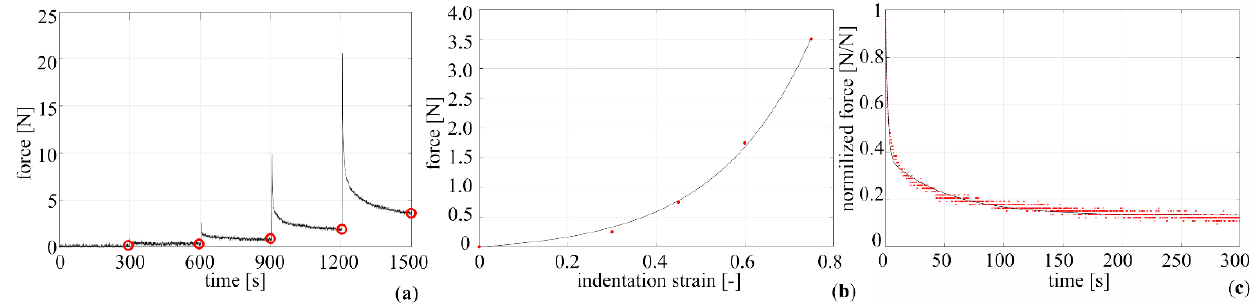
Figure 3. ( a ) Representative force-time output of a VAT specimen with highlighted equilibrium force (red circles). Elaboration of experimental data: comparison of experimental data (red circle) and fitted results (continuous line) for ( b ) force-indentation strain at equilibrium and ( c ) normalized force-time.